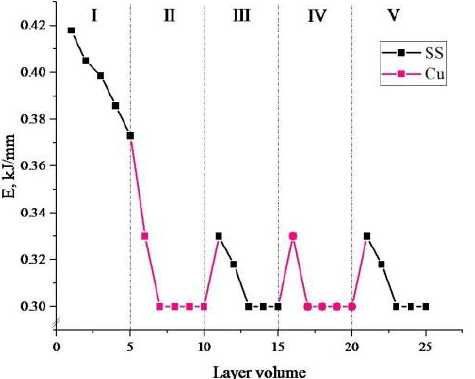
where U and I are voltage and current of the electron beam, and v is the printing speed. Using the data on printing parameters (Table 2) and Formula (1), the dependence of layer-by-layer heat deposition is obtained (Figure 3).